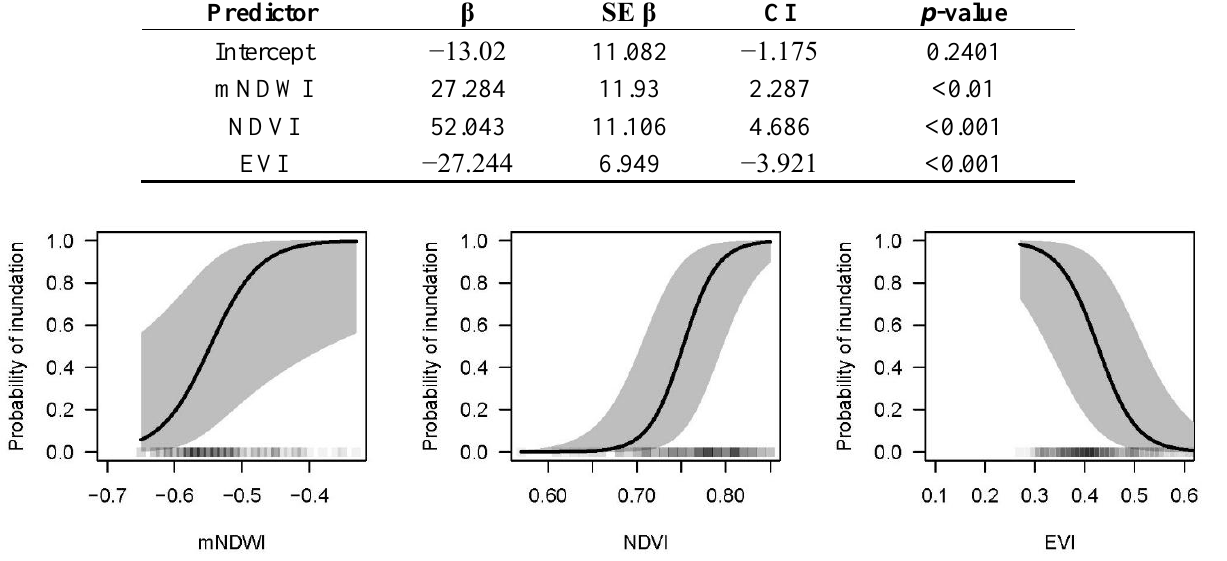
Figure 4. Probability of inundation for MODIS derived water and vegetation indices (mNDWI, NDVI, EVI) determined by the Generalized Linear Mixed Model (GLMM).